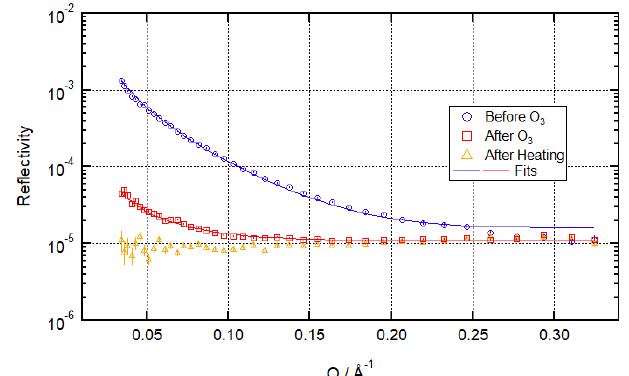
Figure 3. Neutron reflectivity signal from the air–water interface before ozonolysis (blue circles – signal from the pristine oleic acid monolayer), after ozonolysis (red squares – clear signal remain- ing), and after heating (orange triangles – no measurable signal) for ozonolysis of 25µL 1.0gL − 1 d 34 -OA (CHCl 3 spreading solution) on pure water subphase by 323 ± 29ppb O 3 introduced at t = 0s at 3 ± 1 ◦